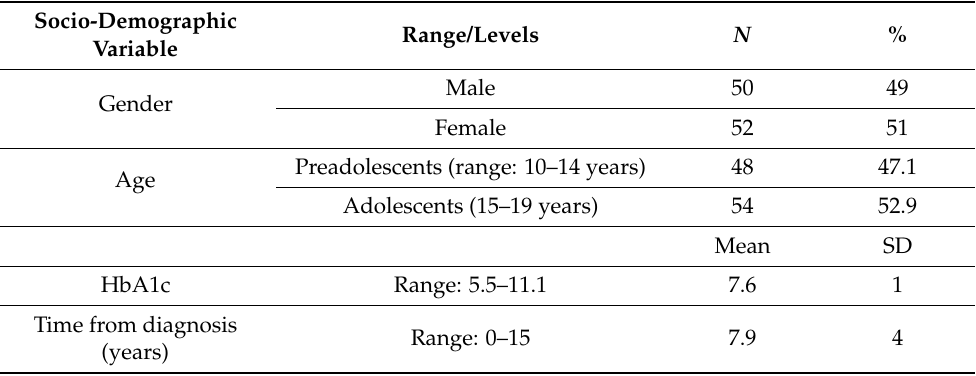
Table 1. Socio-demographic characteristics of patients.